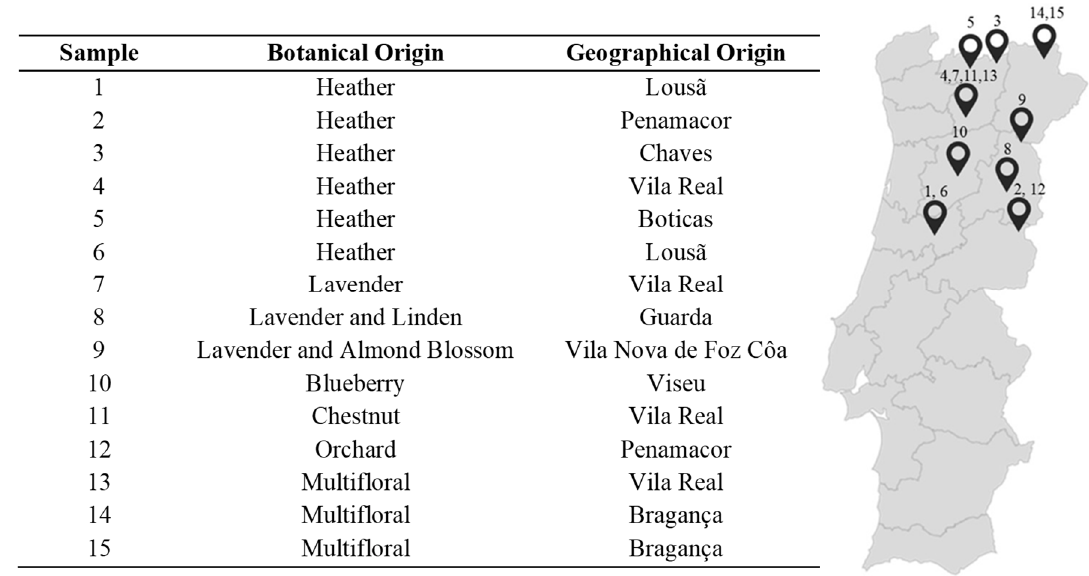
Figure 2. Description of the Portuguese honey samples analysed in this study regarding their botanical and geographical origins.